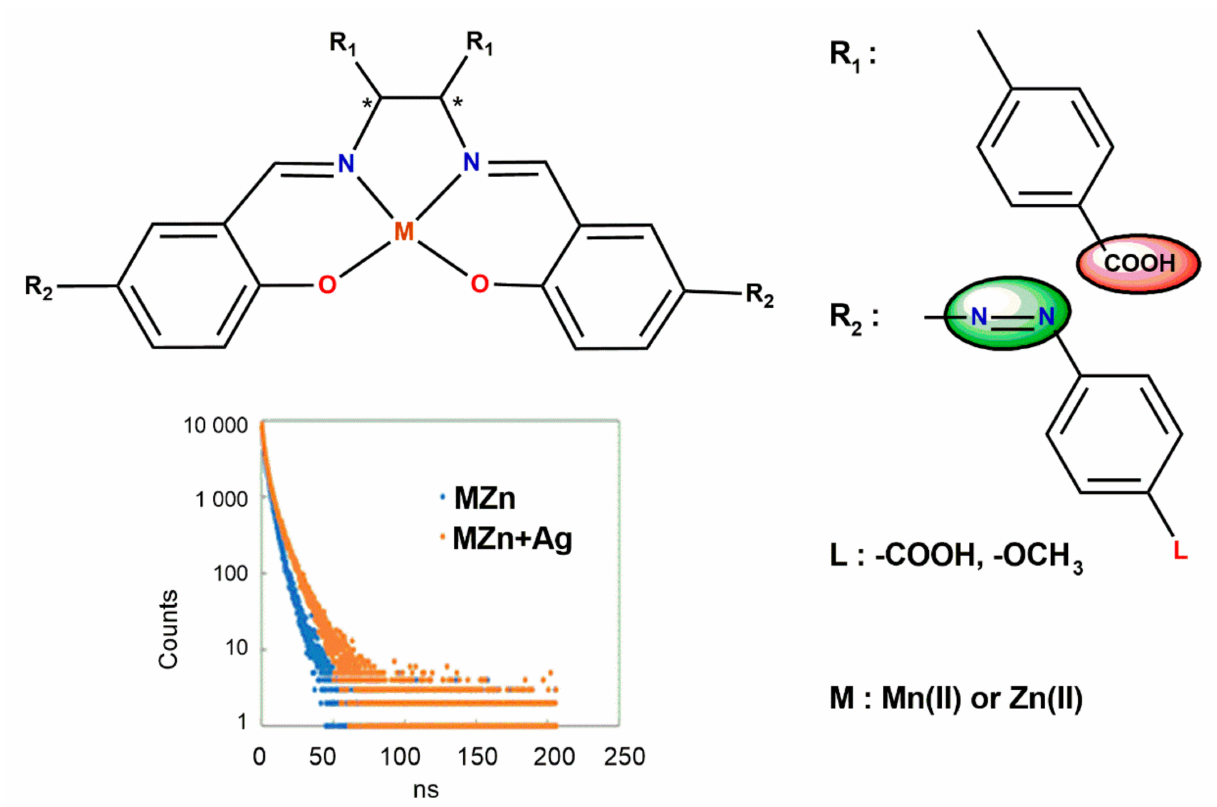
Figure 10. Proposed structure of chiral Schiff base complexes combined with silver nanoparticles and titanium oxide. Long lifetime formed hybrid materials measured with time-resolving luminescence (* denotes an asymmetric carbon atom). Adapted with permission from Ref.